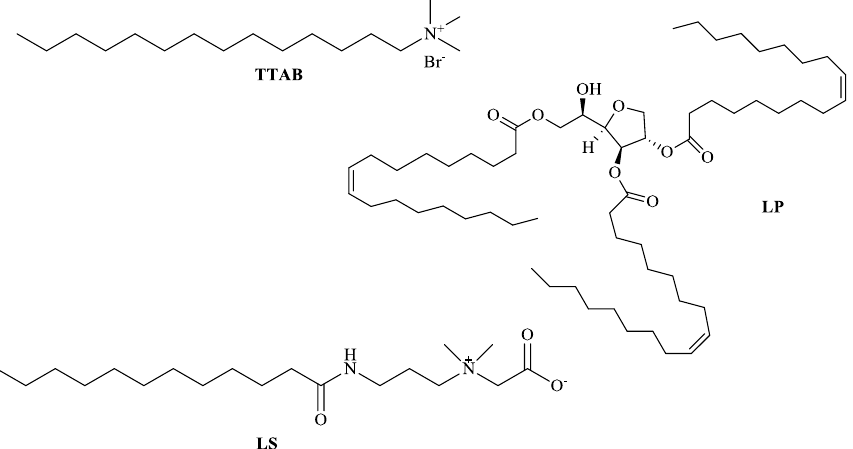
Figure 9. Molecular structures of the softeners used: Tetradecyltrimethylammonium bromide, TTAB, (Z)-(2R,3R,4S)-2-((R)-1-hydroxy-2-(oleoyloxy)ethyl)tetrahydrofuran-3,4-diyl dioleate, LP, 2-((3-dodecanamidopropyl)dimethylammonio)acetate,